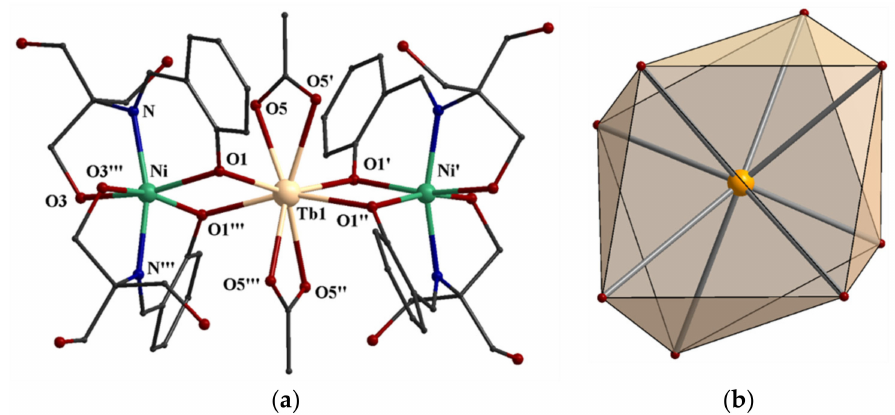
Figure 1. ( a ) Partially labeled plot of the cationic part of 4 . Color code: Ni II green; Tb III tan; O red; N blue; C grey. Symmetry operations: ( (cid:48) ) 1.5- x , 0.5- y , z ; (”) x , 0.5- y , 1.5- z ; ( (cid:48) ”) 1.5- x , y , 1.5- z . ( b ) The square antiprism around the Tb III